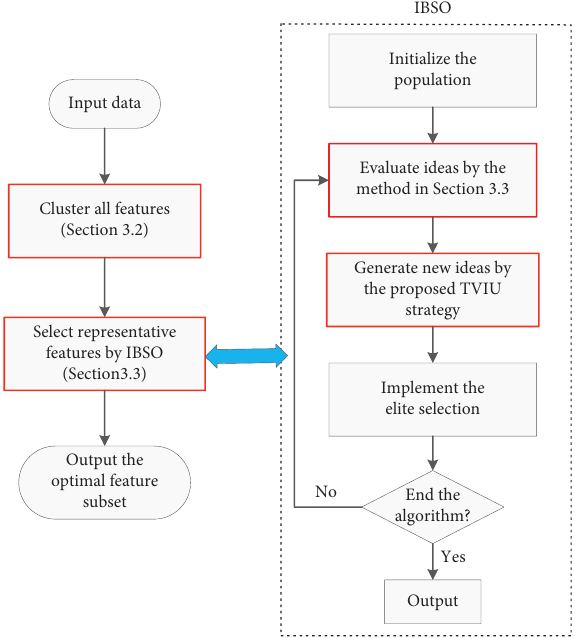
Figure 1: Framework of the proposed